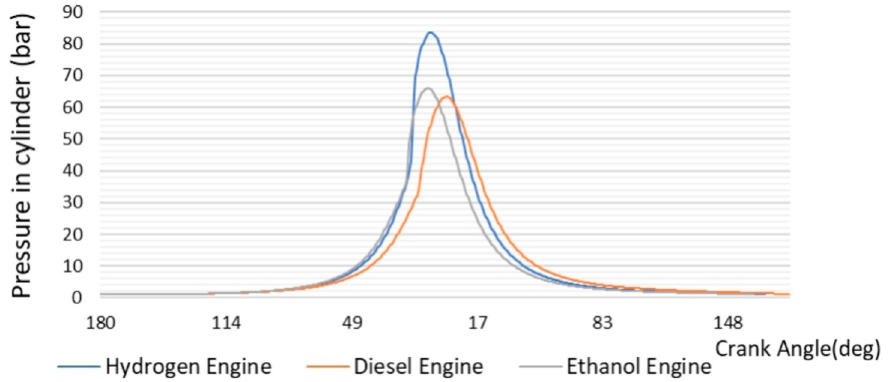
Figure 23. Diesel, ethanol and hydrogen engine in-cylinder pressure.